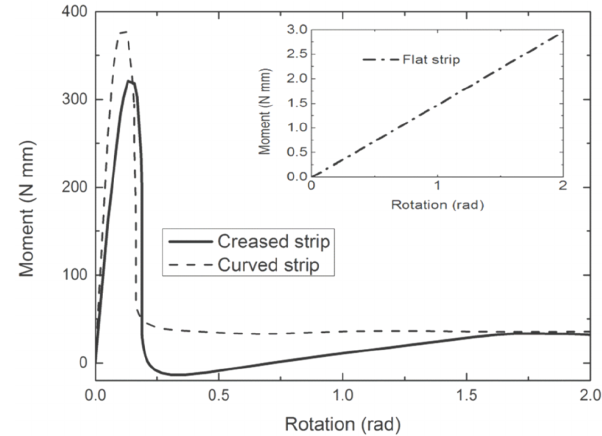
Figure 5. Moment-rotation relationship obtained from finite ele- ment modelling showing the comparison for the flat strip, the curved strip, and the creased